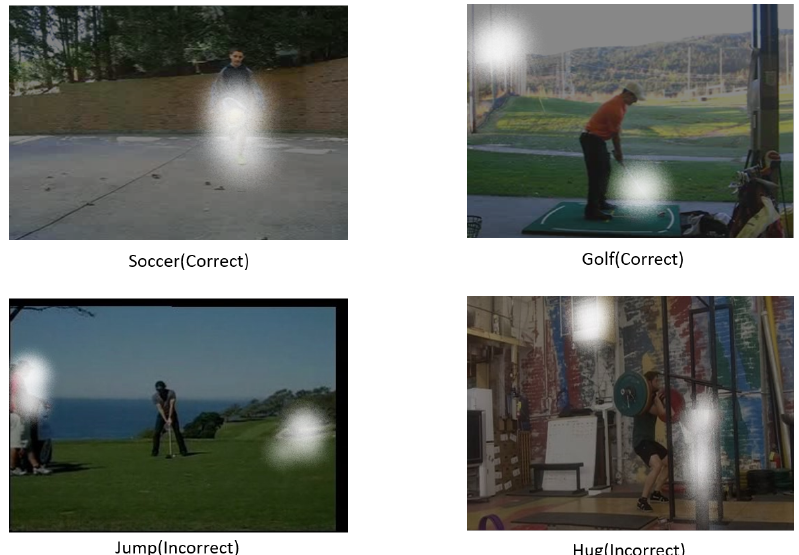
Figure 10. Activity recognition results using visual attention. Soccer and Golf are paying attention correctly ( Top ). But Jump and Hug are wrong ( Bottom